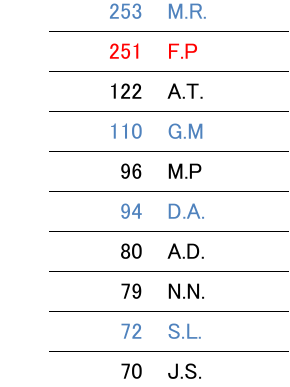
Table 1. The top senders 452 B.R. 253